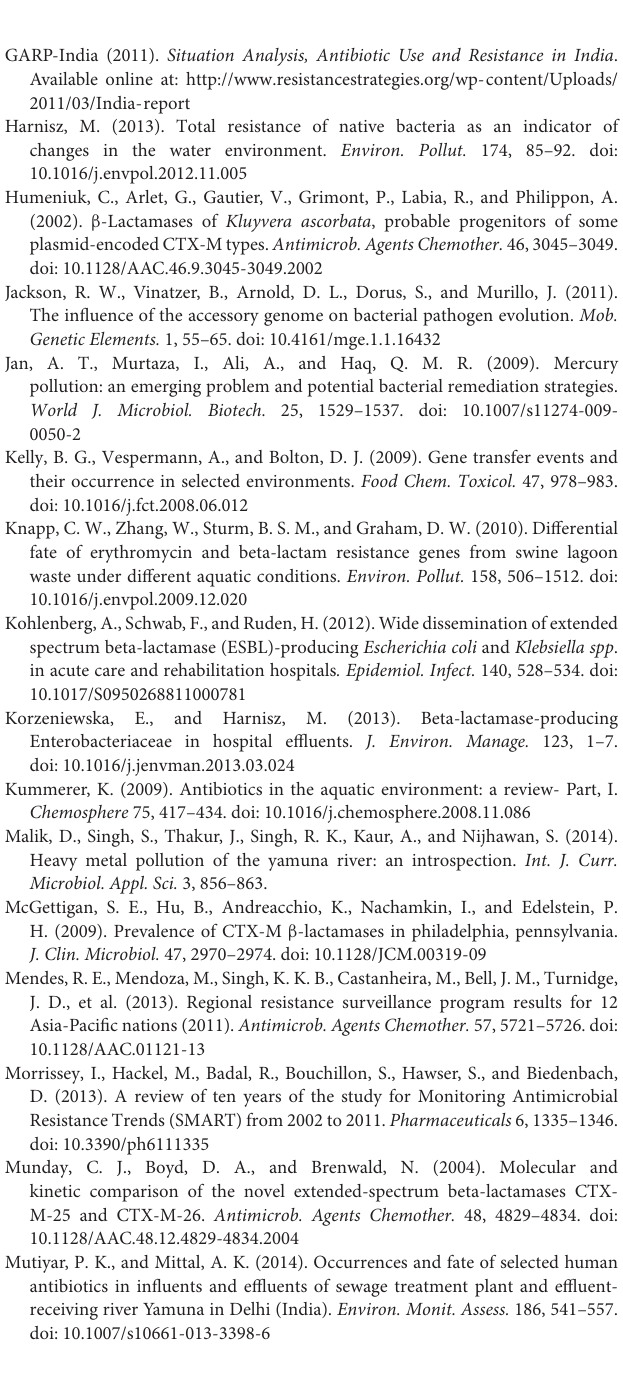
Table S2 | Phenotypic disc confirmatory test of ESBL + bacterial isolates.